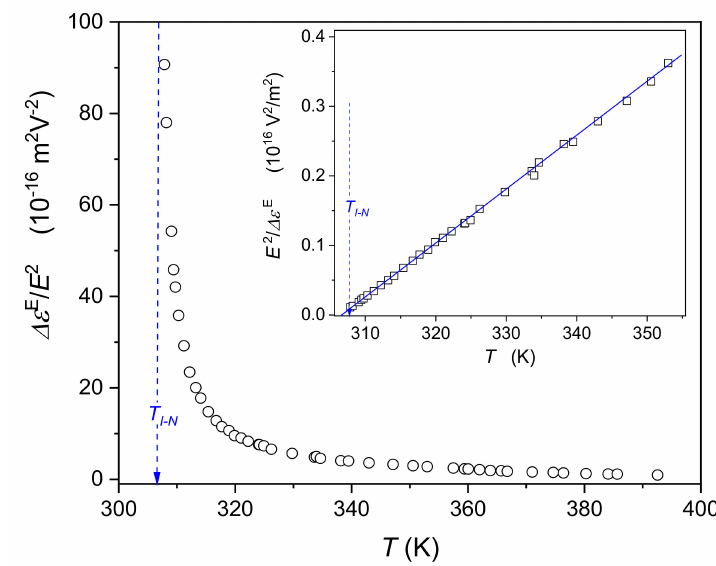
Figure 5. Nonlinear dielectric e ff ect (NDE), describing changes of dielectric constant under the strong electric field, in the isotropic liquid phase of 5CB. The inset shows the reciprocal of experimental data from the central part of the plot, revealing the form of temperature evolution (Equations (1) and